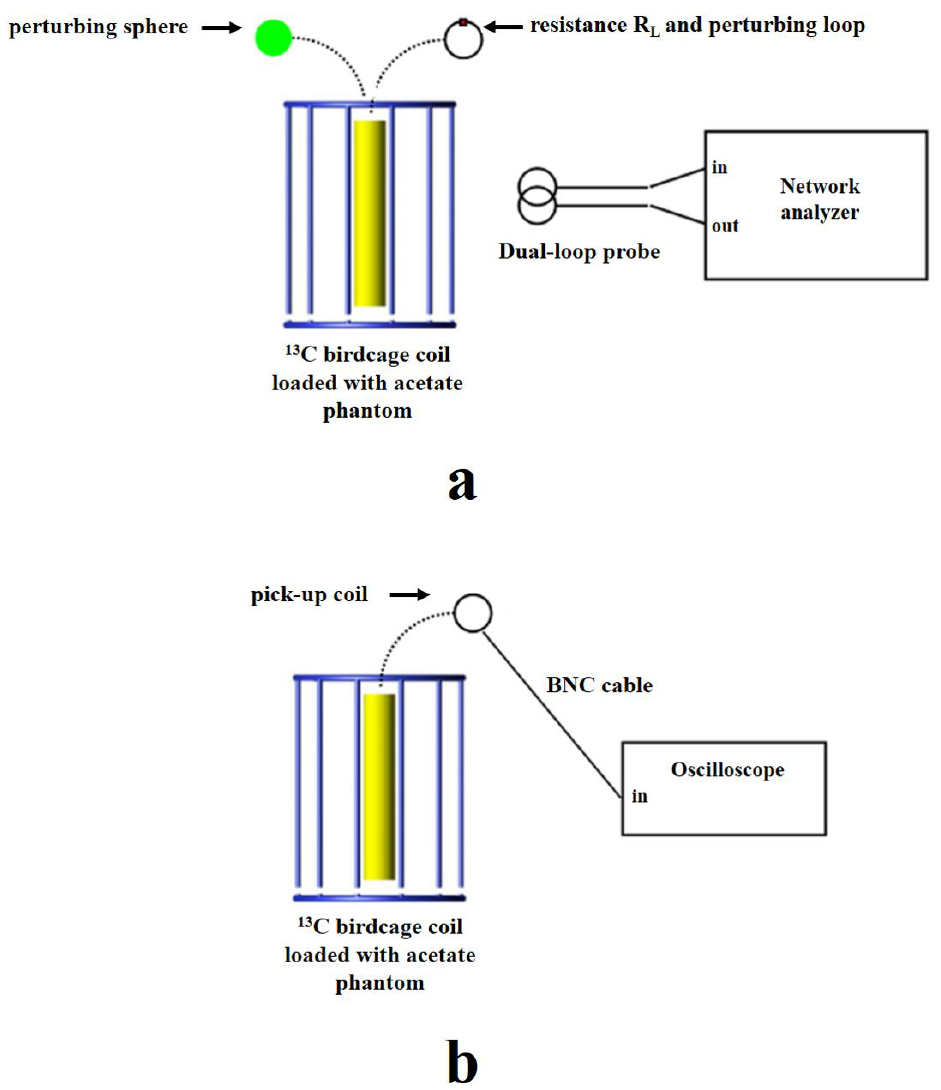
Figure 3. Experimental setups for workbench measurements. ( a ) Perturbing sphere and perturbing loop methods; ( b ) Pick-up coil method. Reprinted by permission from Giovannetti et al.,Measurement 2013 [37].